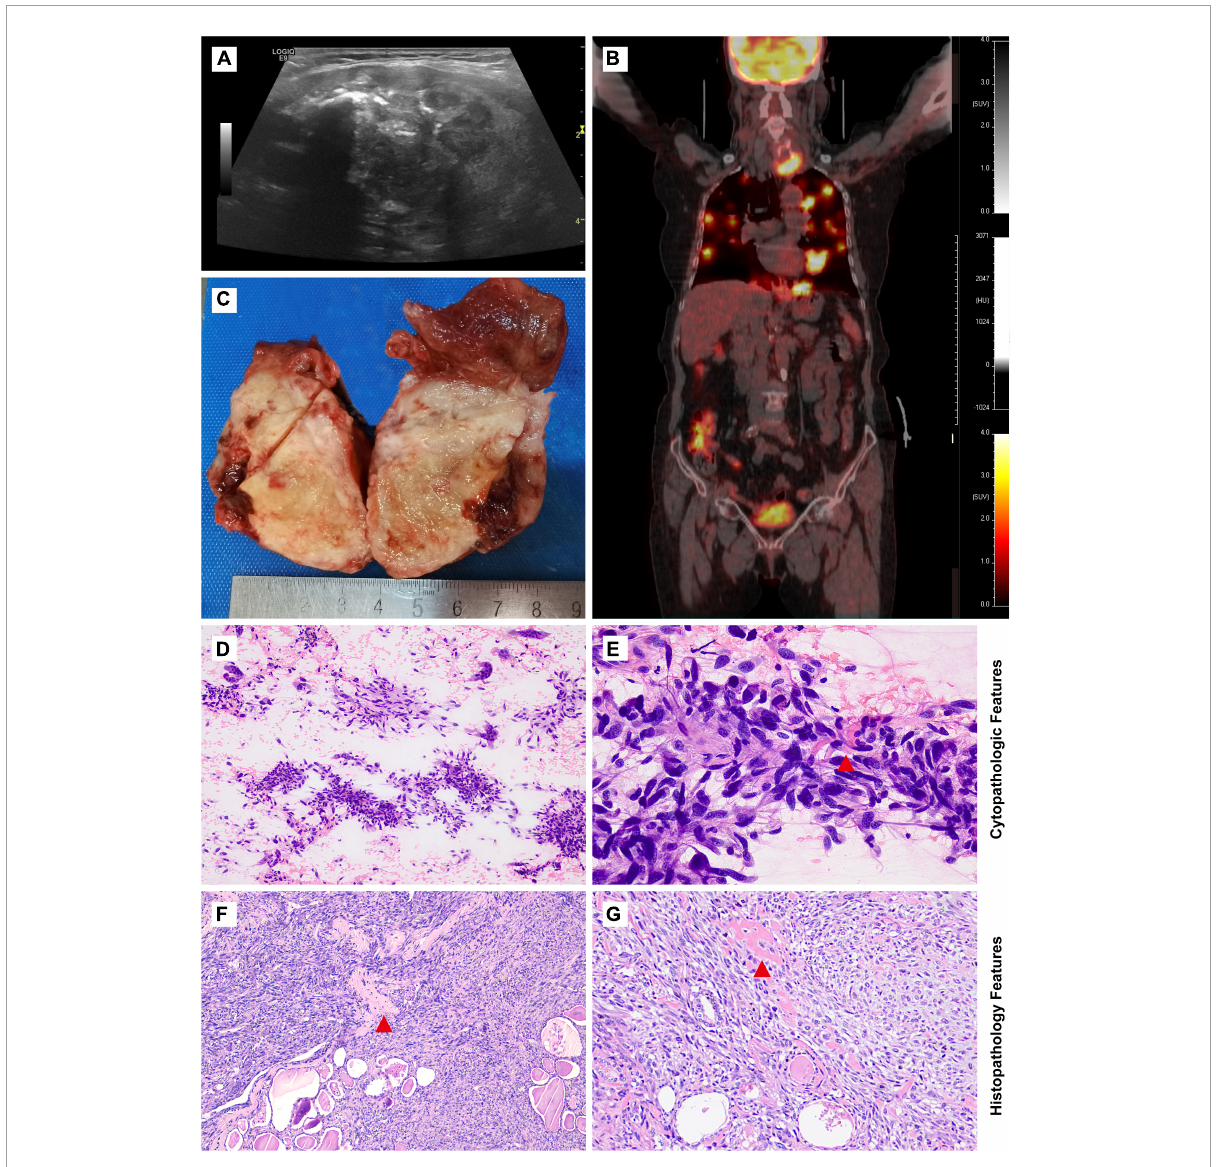
FIGURE1 Imaging studies, macroscopic, cytological, and histological features of thyroid osteosarcoma. (A) Ultrasonic examination revealed an irregular heterogeneous nodule in the left lobe of the thyroid. (B) PET-CT scan showed increased metabolism of FDG in the nodle. (C) Grey-yellow nodule infiltrating normal thyroid tissue could be seen grossly. (D,E) Cytological features from low magnification in (D) and high magnification in (E) . (F,G) Morphological features from low magnification in (F) and high magnification in (G) . Red tangle: Pink lace-like osteoid matrix in cell smear and tissue